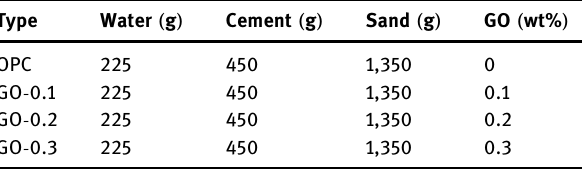
Table 2: Mix compositions for the